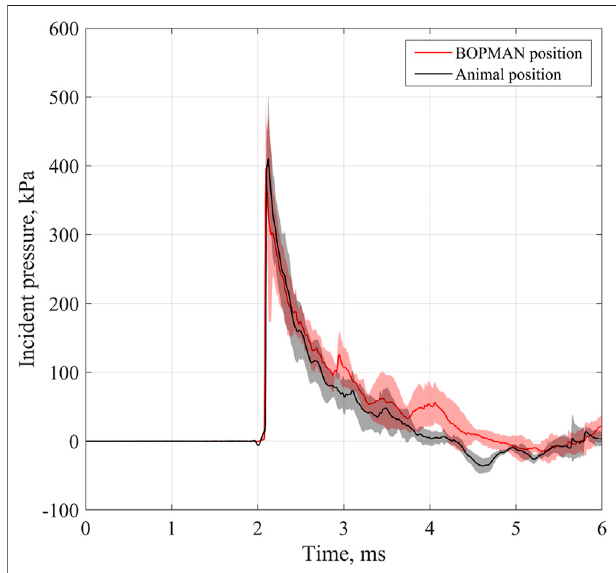
FIGURE 3 | Incident pressure measured near BOPMAN (red line) and near the animal (black line). Solid line represents the mean time history while the shaded area corresponds to the standard